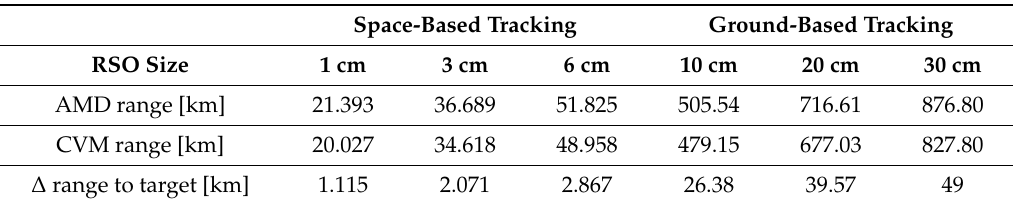
Figure 8. Covariance realism of theoretical uncertainty volume as a function of range to target for Space-Based Radar. Table 5. Max Range-to-Target for 99% Average Mahalanobis Distance (AMD) and CVM Covariance Realism Test Statistic.